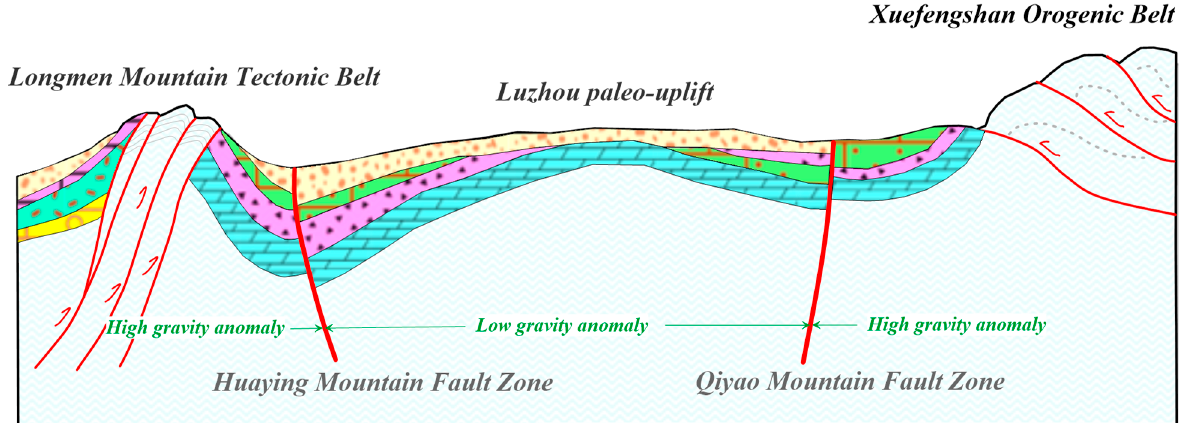
Figure 14. The sketch map of Luzhou paleo uplift evolution.